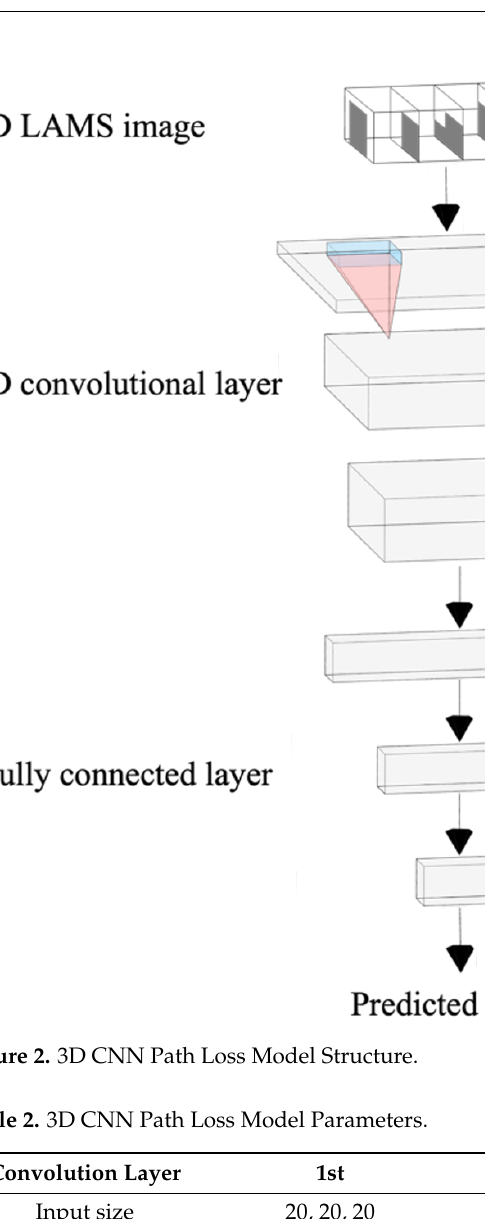
6 of 18 Table 2. 3D CNN Path Loss Model Parameters . Convolution Layer